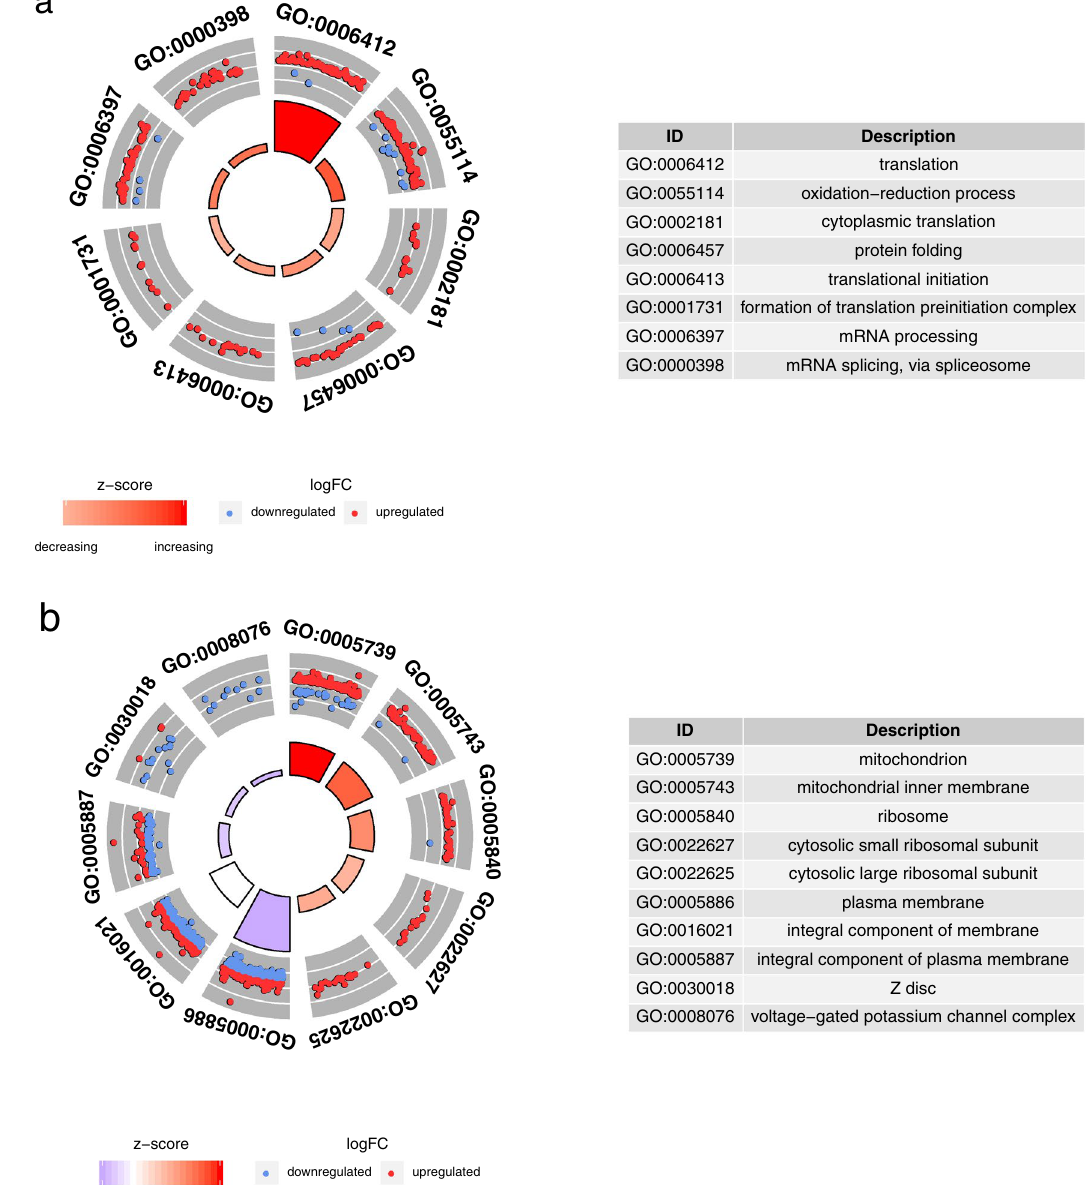
Figure 1. Functionary characterization of differentially expressed genes (DEGs). The outer circle shows scatter plots of the expression levels of DEGs in each enriched GO term. The inner circle represents the z-scores (differences between the number of upregulated DEGs and downregulated DEGs) by colour and the adjusted P -values by height. ( a ) Top 8 enriched GO terms in the BP category. ( b ) Top 5 enriched GO terms in each upregulated and downregulated gene in the CC